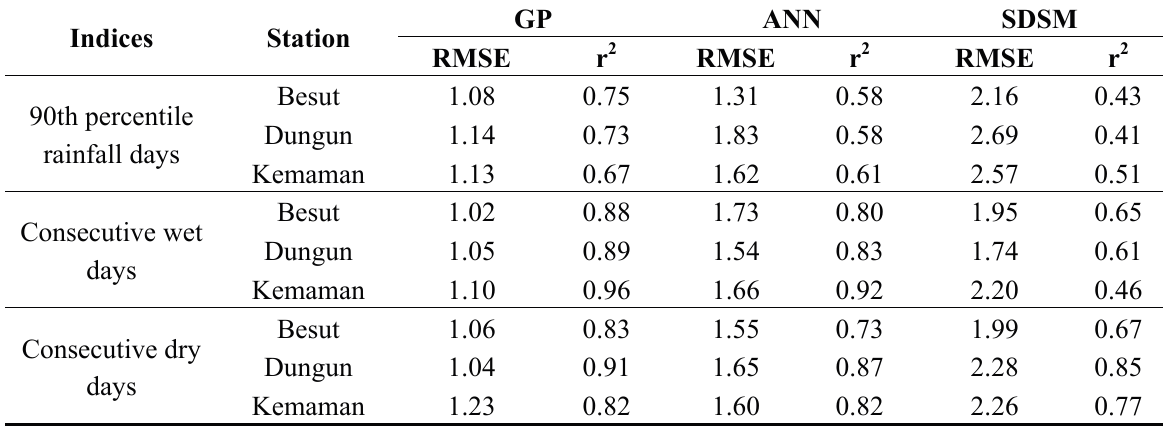
Table 6. The RMSEs and correlation coefficients (r 2 ) between observed and downscaled extreme indices estimated by GP, the ANN and the SDSM during model